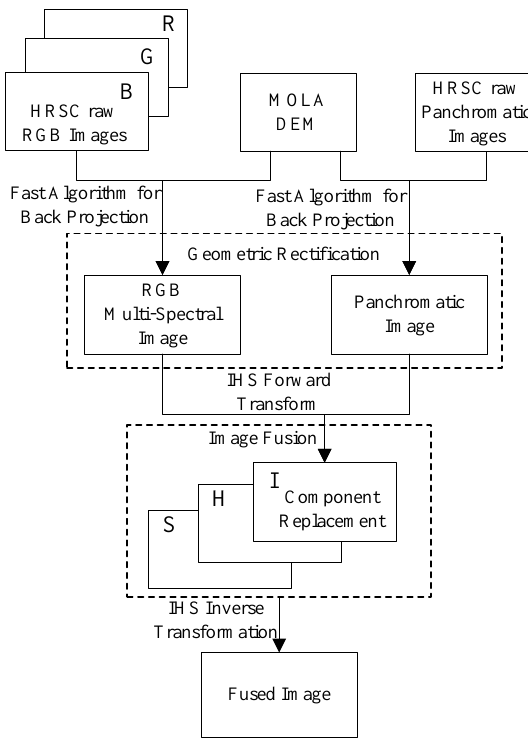
Figure 3. Image fusion procedure of HRSC imagery The procedure of image fusion of Mars Express HRSC image through IHS transformation is as follows.